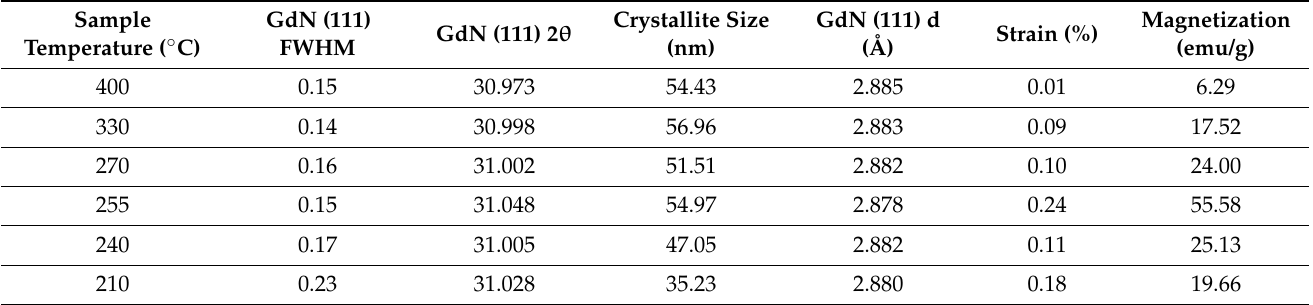
Table 1. Parameters obtained from XRD analysis and magnetization studies at 5 Tesla of Gd films grown on AlN (0001). Note that the equilibrium GdN (111) 2 θ position is 30.97 ◦ . Note that strain is presented as a percent compression relative to the nominal d-spacing calculated from the GdN (111) position in [JCPDS card file No: